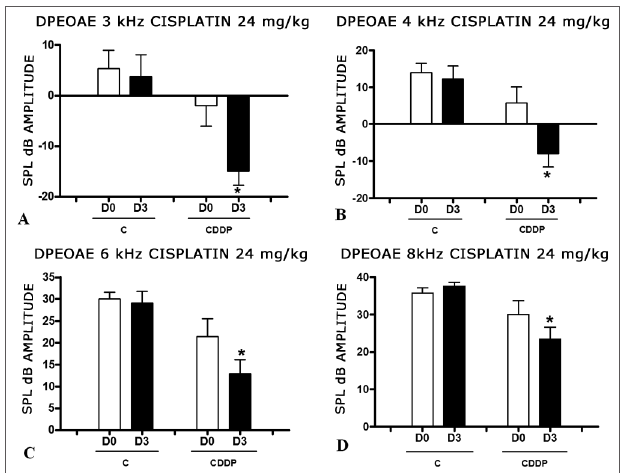
Figure 1. Graph of the DPEOAE amplitude expressed as mean and standard error in the average of days D0 and D3, in groups 1 and 2. The asterisks represent statistical significance. CDDP = cisplatin; C = control. Graph A: 3 kHz frequency (Test T: * p = 0.0095 - D3 x D0 CDDP).